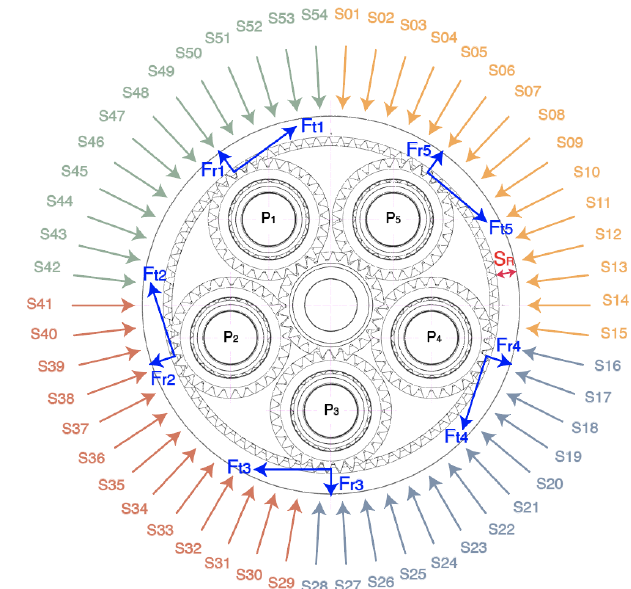
Figure 2. Rotor side view of the middle section of the first planetary stage with the angular location of the strain sensors (S01 to S54). S R is the ring gear rim thickness, and F t i and F r i are the tangential and radial gear mesh loads from the i th planet ( P i